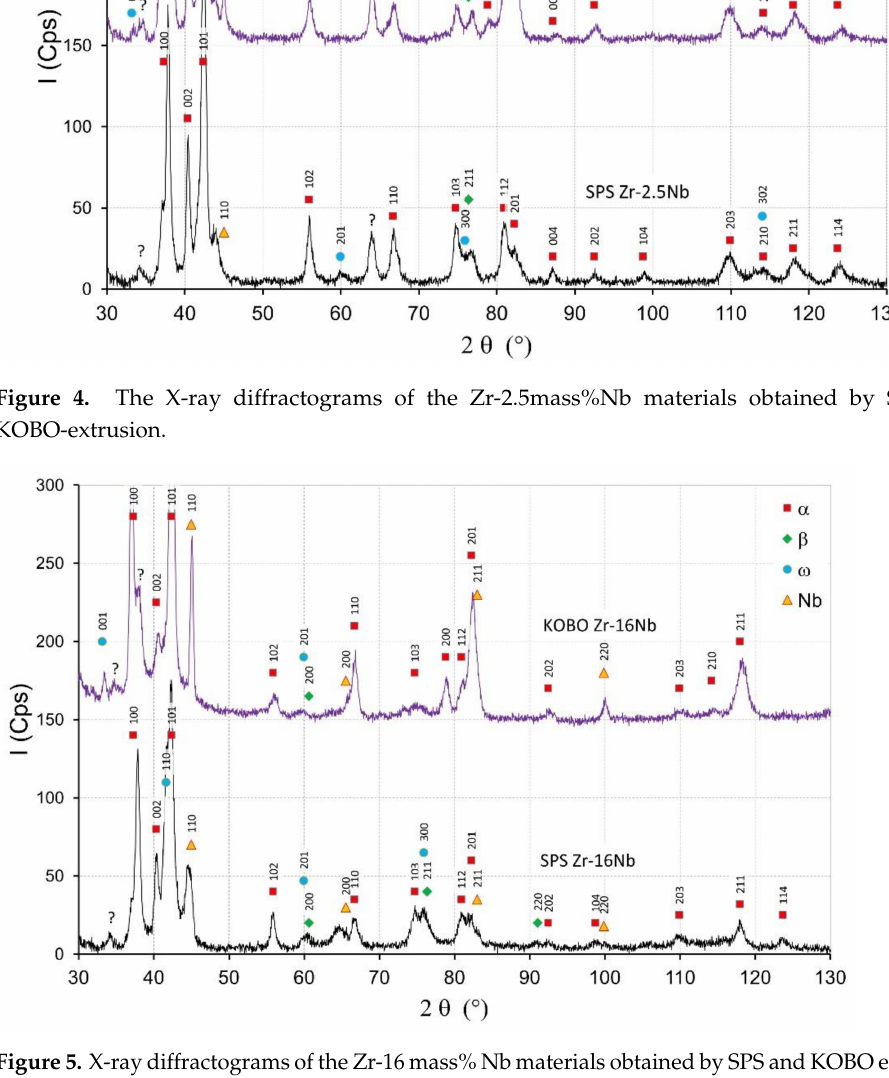
Figure 5. X-ray diffractograms of the Zr-16 mass% Nb materials obtained by SPS and KOBO